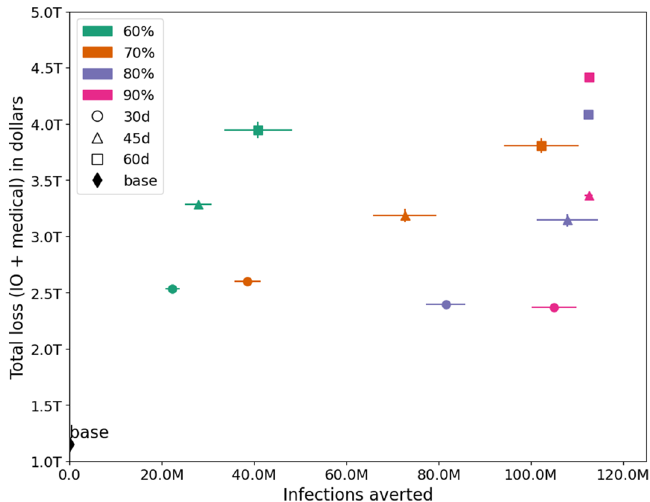
Figure 6. Trade-off between the number of infections averted and economic losses under each scenario. The vertical and horizontal bars show the inter-quartile range.